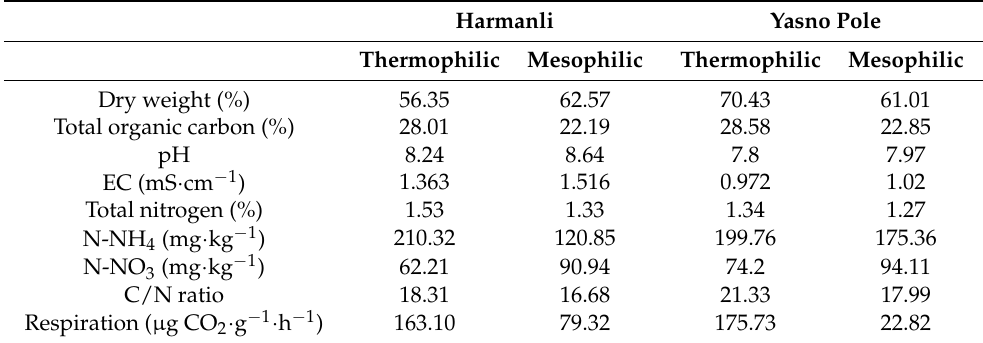
Table 1. Physicochemical parameters of the compost during sampling in the thermophilic and mesophilic phases of both studied sites: Harmanli and Yasno pole.